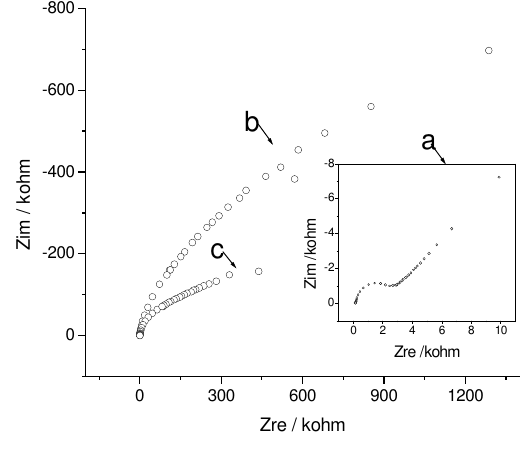
Figure 6. Electrochemical impedance spectra. (a) a bare gold electrode, (b) DEC SAM/Au, (c) (b) after accumulating prochlorperazine or ethopropazine. Bias: 0.2 V; probe concentration: 1 mM Fe(CN) 63- /Fe(CN) 64- . Linear calibration